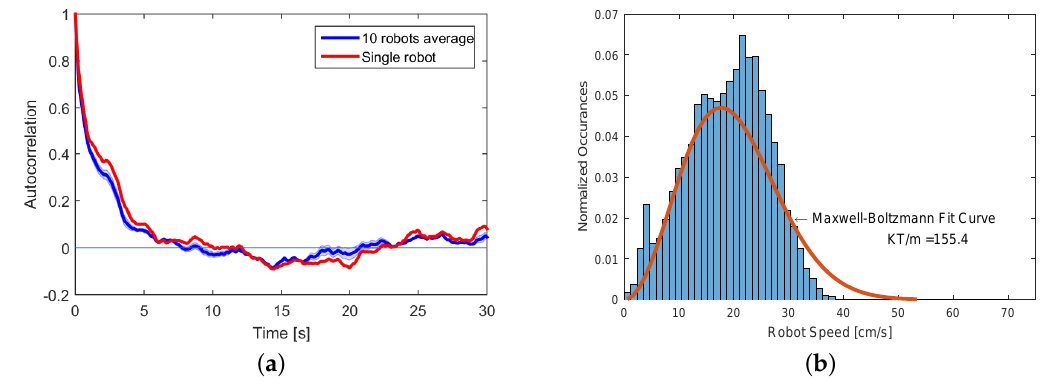
Figure 14. Macroscopic kinetics of the system. ( a ) Autocorrelation of the speed (i.e., magnitude of velocity) for Lily robots. The speed is uncorrelated to its initial value after approximately 5 s. The shaded area signifies one standard deviation interval; ( b ) Distribution of the robots’ speeds acquired based on the tracking data with normalized occurrences (total sum of one).